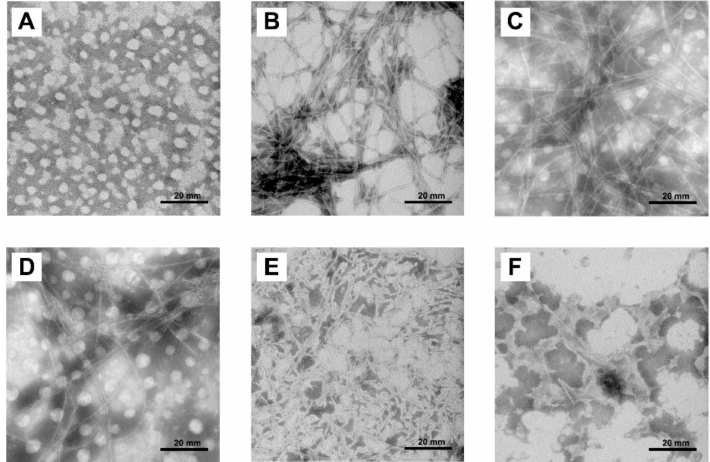
Figure 4. Morphology changes of hIAPP aggregates. Representative TEM images of ( A ) monomeric hIAPP. ( B ) formed fibrils by monomeric hIAPP after 48 h. ( C ) monomeric hIAPP co-incubated with 2.5 mg / mL of COS for 48 h. ( D ) monomeric hIAPP co-incubated with 5.0 mg / mL of COS for 48 h. ( E )